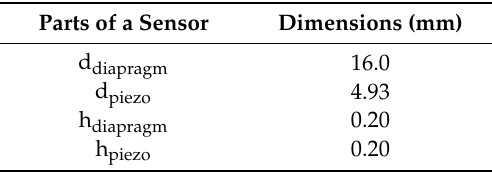
Table 1. Dimensions of the constructed piezoelectric pressure sensor, which have been chosen based on the results of the numerical modelling and given manufacturing limitations.